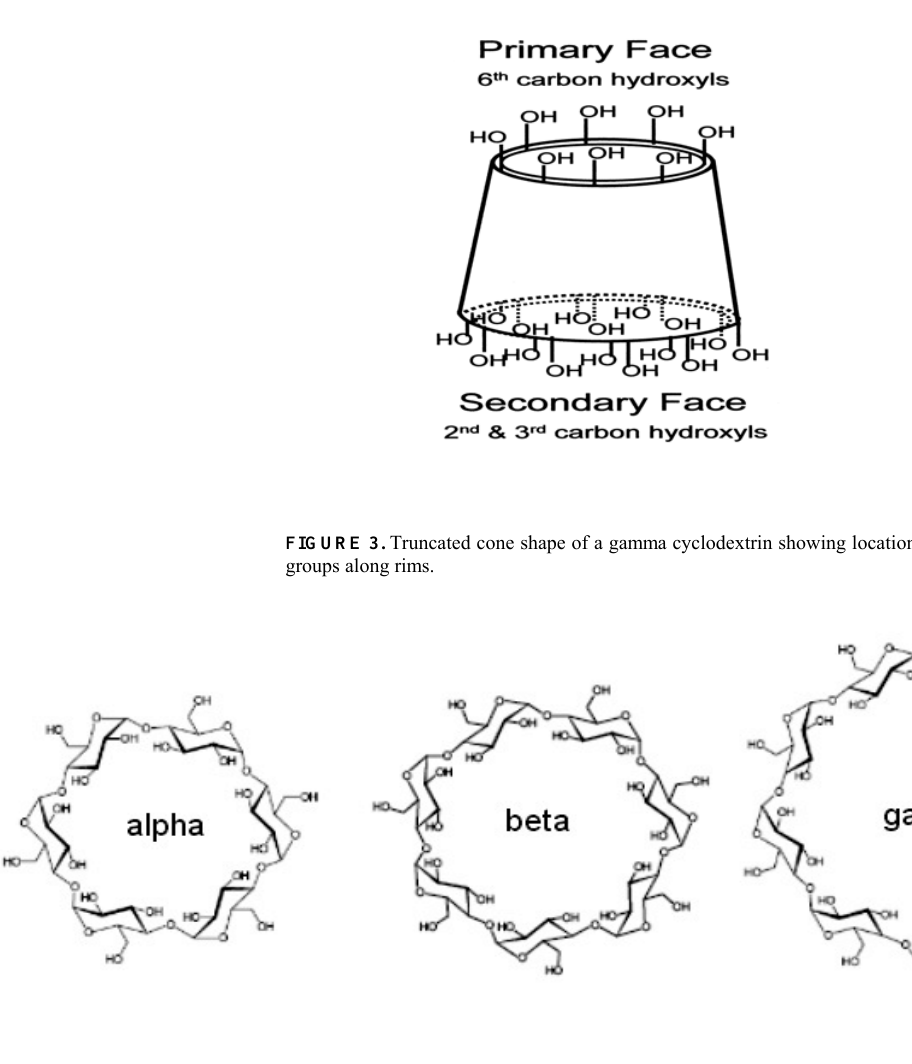
FIGURE 4. Naturally occurring cyclodextrins, alpha, beta, and gamma. (Reprinted with permission Wacker Chemical Corp. Adrian MI.